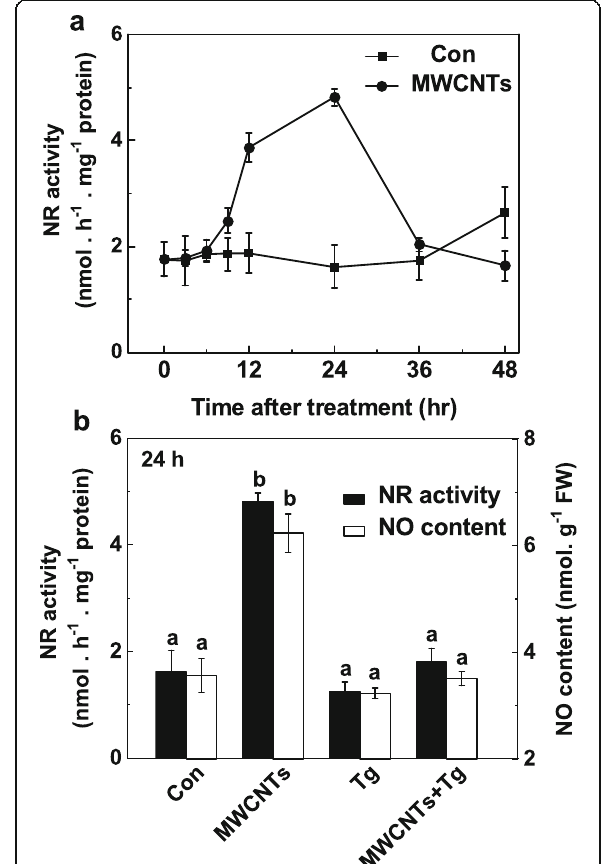
Fig. 7 MWCNT-induced NO production was blocked by tungstate, an inhibitor of NR. Three-day-old tomato seedlings were treated with distilled water and 5 mg/mL MWCNTs with or without 20 μ M tungstate (Tg). Changes in NR activity ( a ) and NO production ( b ) determined using Greiss reagent method. Data are the means ± SE. Bars denoted by the same letter did not differ significantly at p < 0.05 level according to Ducan ’ s multiple